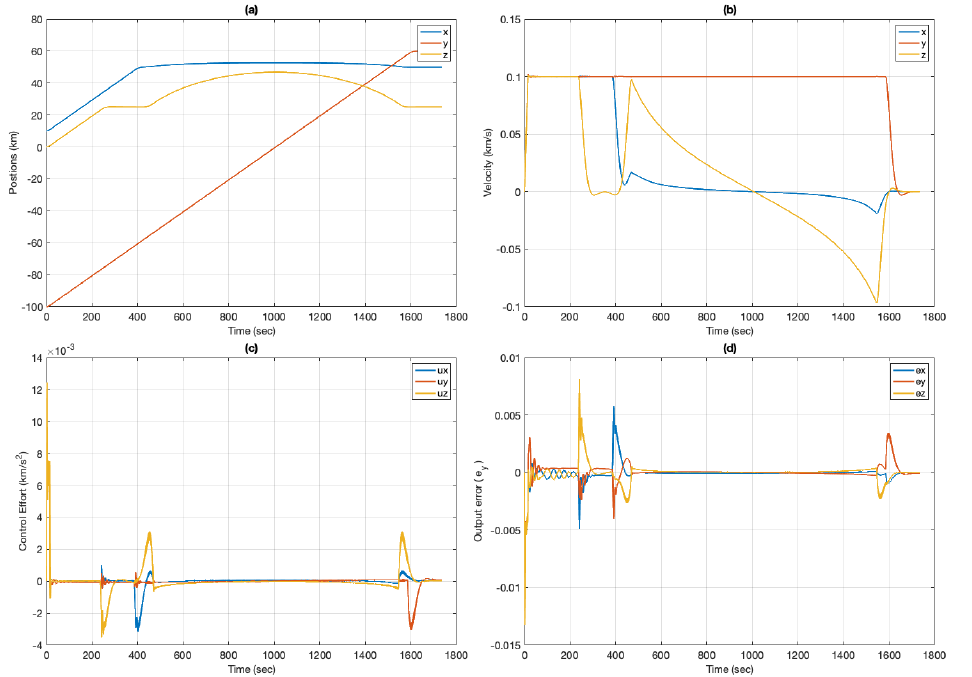
Figure 9. Plots for adaptive control case for asteroid Kleopatra: ( a ) position vs. time; ( b ) velocity vs. time; ( c ) control effort vs. time; ( d ) output error vs.